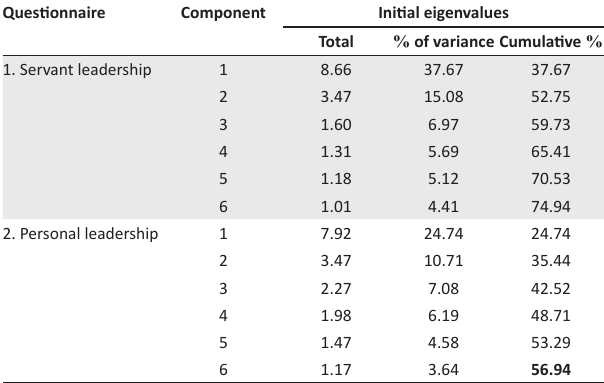
TABLE 2: Initial eigenvalues for the total variances